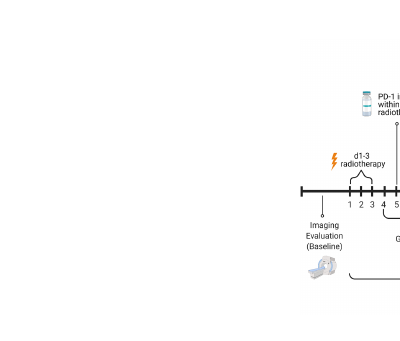
FIGURE 1 | Treatment schedule of the